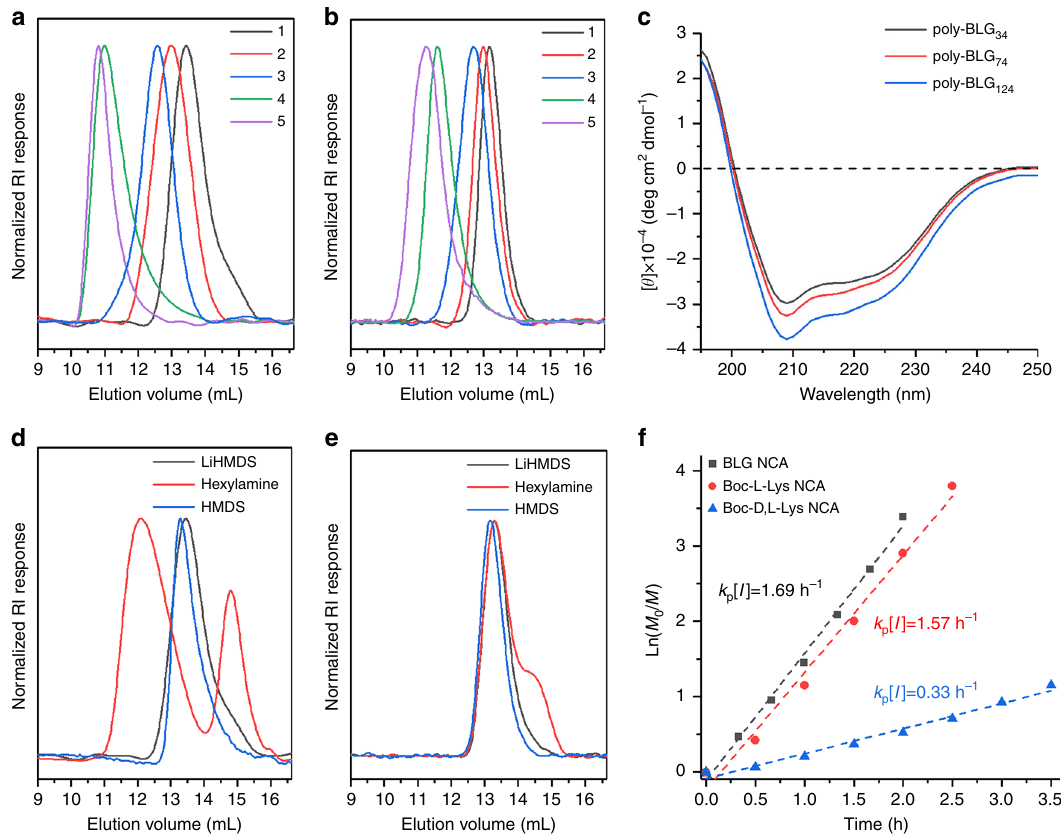
Fig. 2 Characterization of polypeptides synthesized from LiHMDS-initiated NCA polymerization. a GPC traces of poly-BLG corresponding to entry 1 – 5 in Table 1; b GPC traces of poly-Boc-D,L-Lys corresponding to entry 1 – 5 in Table 2; c CD spectra of poly-BLG at variable DP prepared from LiHMDS-initiated NCA polymerization; d single peak GPC traces and bimodal GPC trace obtained from LiHMDS, HMDS and n-hexylamine initiated BLG NCA polymerization, respectively; e single peak GPC traces and bimodal GPC trace obtained from LiHMDS, HMDS and n-hexylamine initiated Boc-D,L-Lys NCA polymerization, respectively; f reaction rates of LiHMDS initiated BLG NCA, Boc-L-Lys NCA and Boc-D,L-Lys NCA polymerization in THF with NCA:initiator ratio of 100:1 and initial NCA concentration at 0.2 M; k p [I] represents the rate of polymerization reaction, whereas k p is the rate constant of the polymerization and [I] is the concentration of initiator. All full scale GPC traces were included in the Supplementary Figs. 45 – Table 2 Characterization of poly-Boc-D,L-Lys prepared using Table 3 Polypeptides synthesized from LiHMDS-initiated different initiators